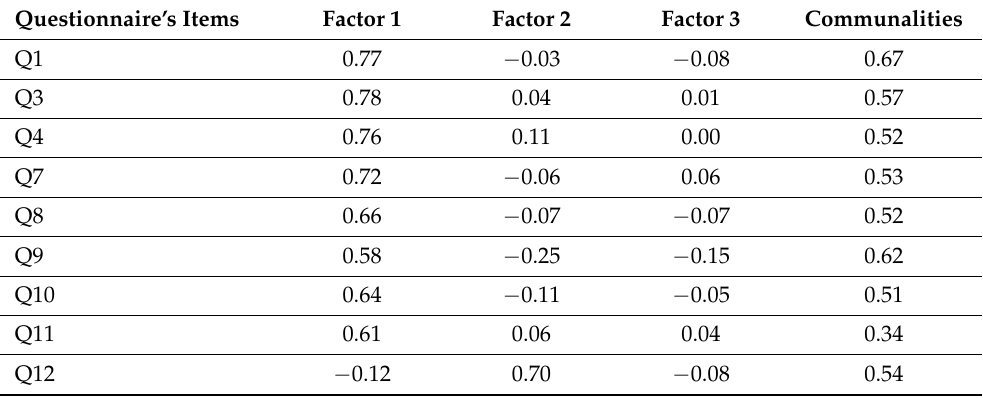
Table 3. Factor loading of the PTIDB